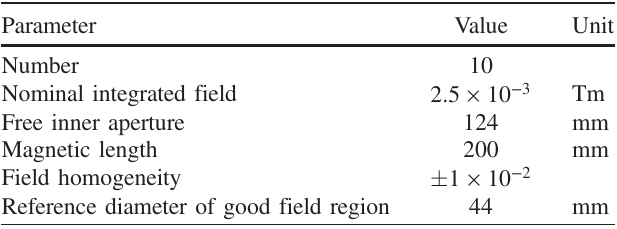
TABLE XI. Parameters of ELENA H = V corrector magnets.